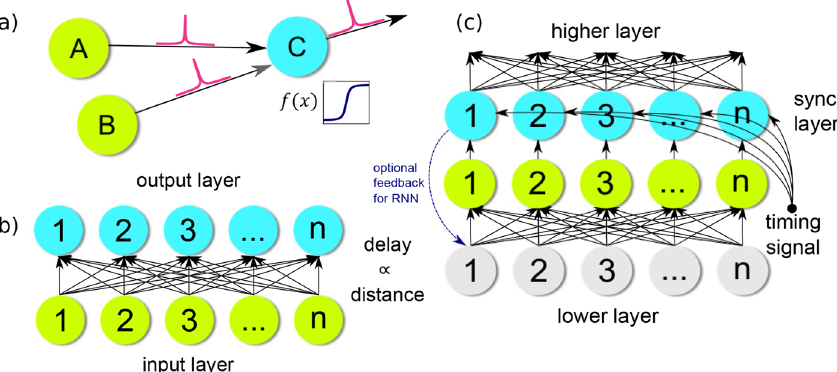
Figure 1. When neuron A and neuron B fire simultaneously, and if both neurons are equidistant from neuron C, then the pulse propagating from A to C will arrive at C at the same time as the pulse propagating from B to C ( a ). The threshold at C is set such that it is higher than the amplitude of either individual pulse. Neuron C will fire if, and only if, both pulses arrive time-synchronized. In this way neuron C acts as a coincidence detector. Each input layer neuron is connected to every output layer neuron with a delay proportional to the distance between the input and output points in Euclidean space ( b ). If all activated input neurons fire simultaneously, and only one pulse is allowed per cycle, the output node with highest symmetry will be the output node with the greatest number of pulses arriving simultaneously. To detect hierarchical geometric symmetry a synchronization layer is added above the original output layer ( c ). The synchronization layer has a slower integration time than the original output layer, storing the pulses until a timing signal releases them to the next higher layer simultaneously. In recurrent variations of the network (e.g. RNN, recurrent neural network), feedback from the output of the synchronization layer is connected back to a lower level input layer. See text for details of operation.